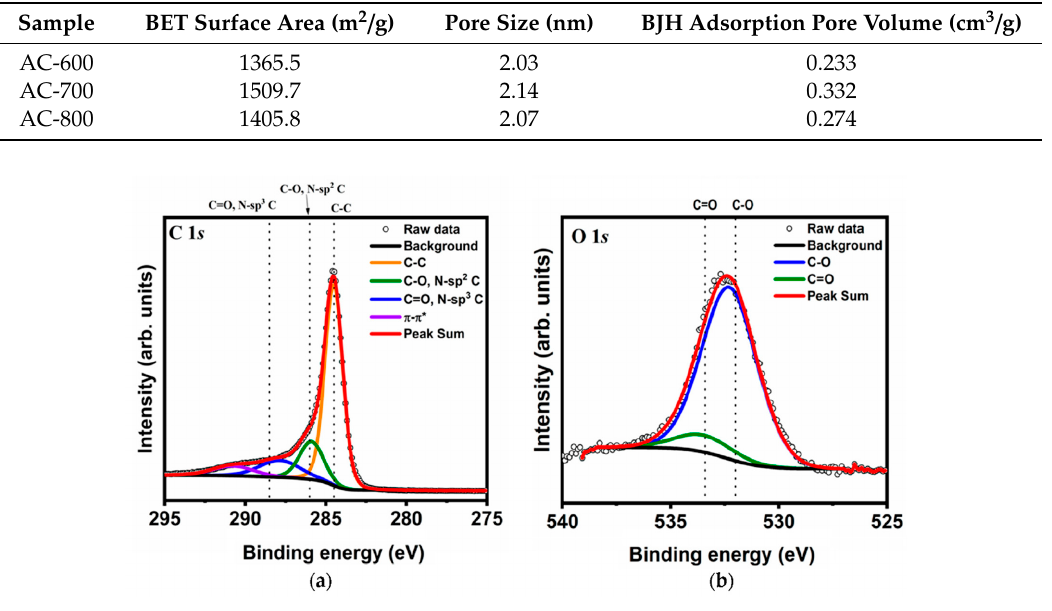
Figure 3. XPS patterns of AC-700 ( a ) C1s and ( b ) O1s.